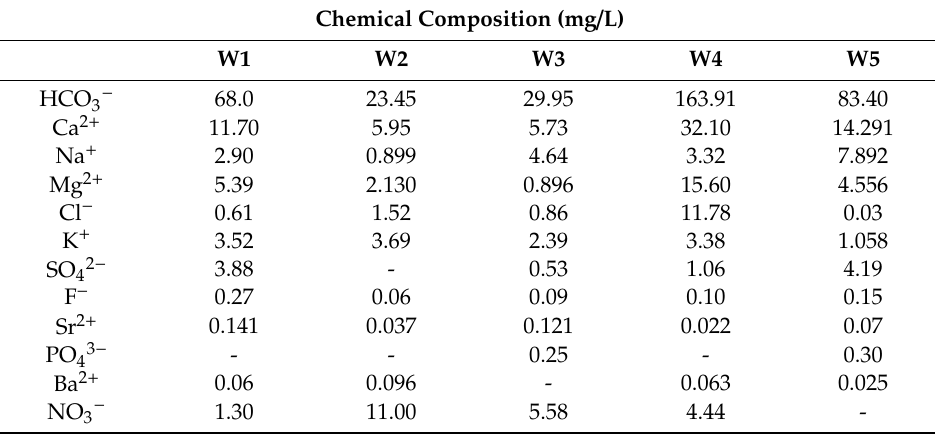
Table 1. Chemical composition of commercial waters, as declared by their